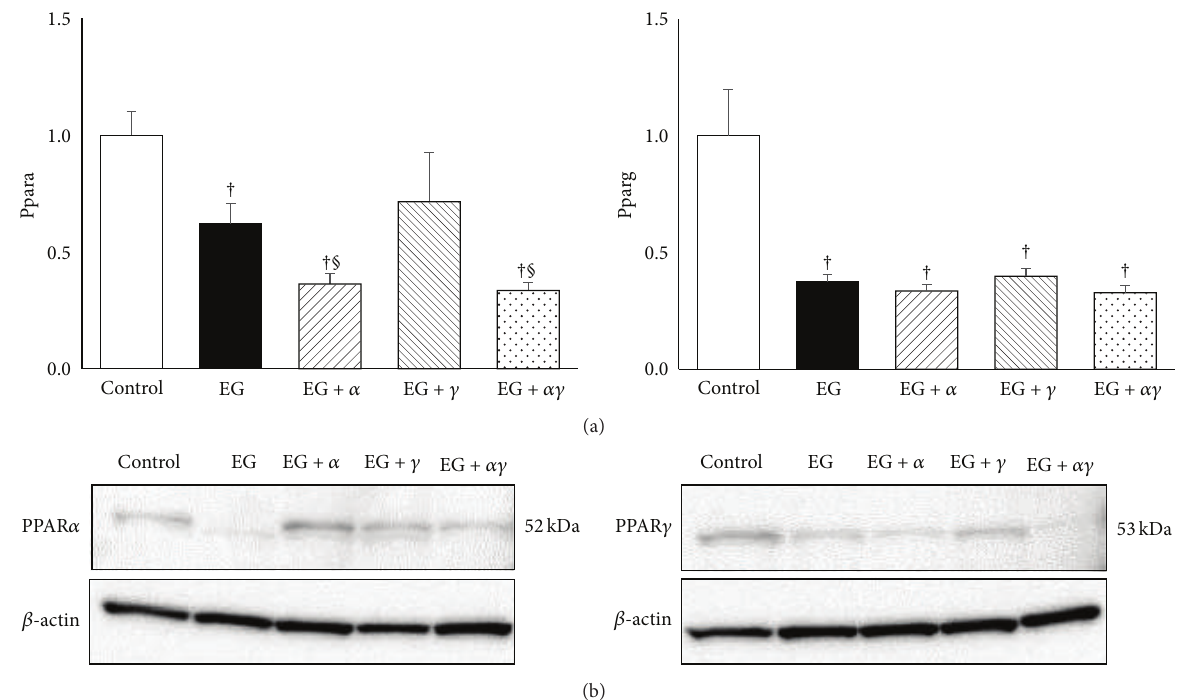
Figure 3: PPAR 𝛼 and PPAR 𝛾 gene expression in model rat kidneys. (a) Gene expression was assessed by qRT-PCR using TaqMan assays ( 𝑛 = 6 for all groups). Data are presented as mean ± SE. † 𝑝 < 0.05 compared with the control group; § 𝑝 < 0.05 compared to the EG group. (b) Western blotting of rat kidneys for PPAR 𝛼 and PPAR 𝛾 protein expression. The molecular mass of PPAR 𝛼 and PPAR 𝛾 was confirmed by bands at 52 and 53 kDa,